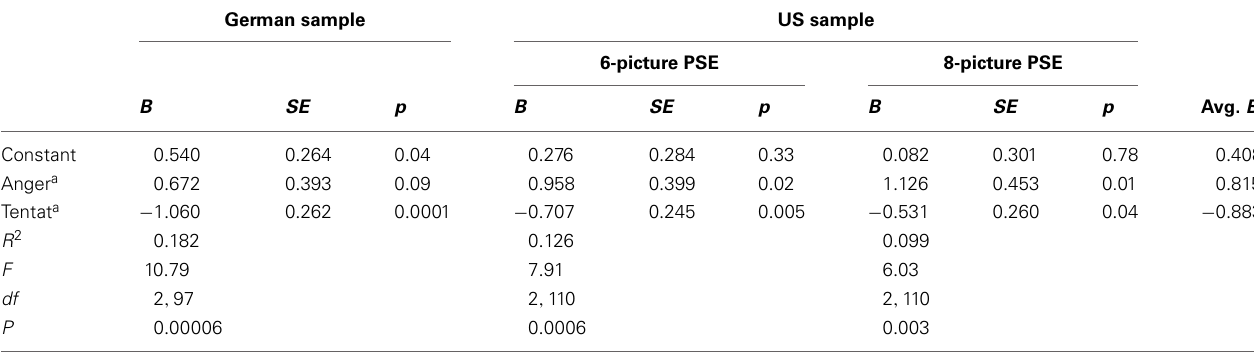
Table 3 | Simultaneous regression of n Power scores (residualized for word count) on LIWC 2001 categories that are significant zero-order predictors in both samples and are non-redundant (Study 1).